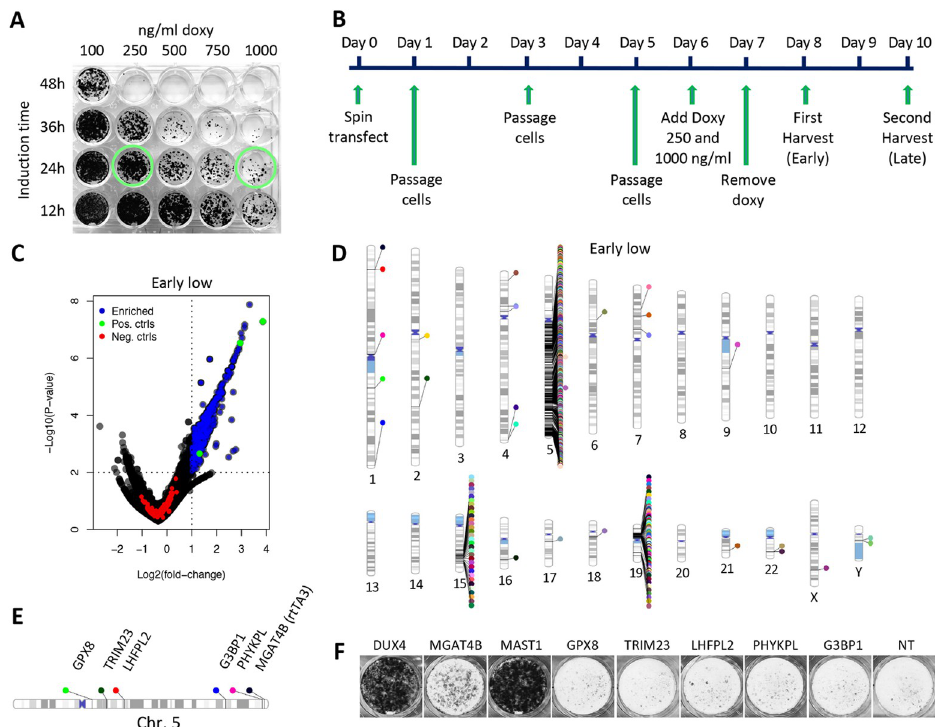
Fig 3. CRISPR Screen setup and discovery of a CRISPR/Cas9 screening artefact. (A) Viability staining of DIE cells treated with doxycycline (Doxy) concentrations (100, 250, 500 or 1000ng/ml) and for different exposure times (2, 4, 6, or 8h) to determine the optimal concentration and exposure time to induce sufficient cell death rates in DIE cells. Green circles indicate which conditions (low Doxy: 250ng/ml high Doxy: 1000ng/ml); were used for the genome-wide CRIPSR/Cas9 screen. (B) The CRISPR/Cas9 screen timeline from the time of library transfection (Day 0) to the final harvest of surviving DIE cells (Day 10). 6 days after transfection of the library, Doxycycline (Doxy) was added for 24h to induce DUX4 expression. Low Doxy: 250ng/ml; high Doxy: 1000ng/ml; early harvest: 24h after Doxy removal; late harvest: 48h after Doxy removal. (C) Volcano plot showing the enrichment of sets of guides of the low doxycycline 250ng/ml) -early harvest (24h after doxycycline removal) screen (early-low). Blue points represent guide sets that are significantly enriched (P-value � 0.01), LFC � 1), green points are the positive controls (DUX4, MAST1, MGAT4B), red points represent the non-target/negative control guides. (D) Chromosomal ideogram indicating the location of enriched hits in the human genome, of the low doxycycline-early harvest screen (see panel B). (E) Schematic representation of the location of a small number of false positive hits on chromosome 5 and chromosome 19. (F) Viability staining demonstrating surviving DIE-Cas9 cells (DIE cells constitutively expressing Cas9) after 250ng/ml doxycycline exposure, containing knockouts of the same genes mentioned in (E), but also DUX4, MGAT4B and MAST1. Media did not contain any selection markers (blasticidin or puromycin) to select for the presence of the rtTA3 or the DUX4 transgene. NT: Non-target